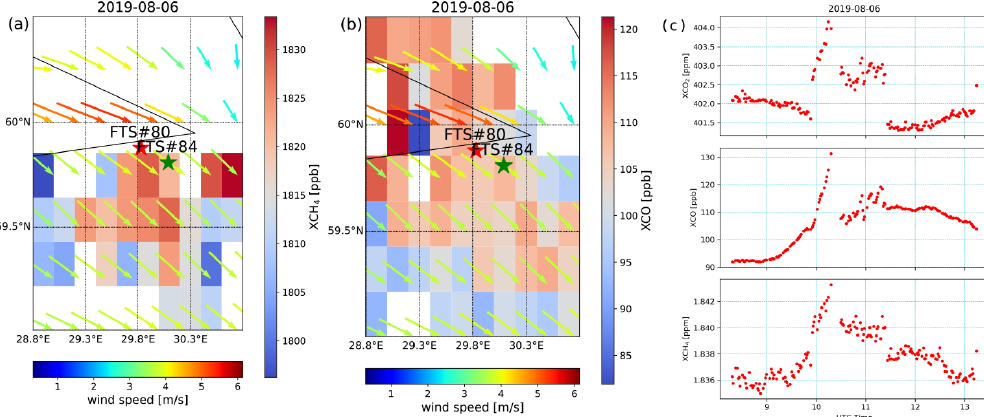
Figure A1. Spatial distribution of XCH 4 (a) and XCO (b) on a 0 . 1 ◦ × 0 . 1 ◦ latitude × longitude grid together with the ERA5 wind at 12:00UTC, and (c) daily time series of XCO 2 , XCO and XCH 4 (top, middle and bottom panels, respectively) on 6 August